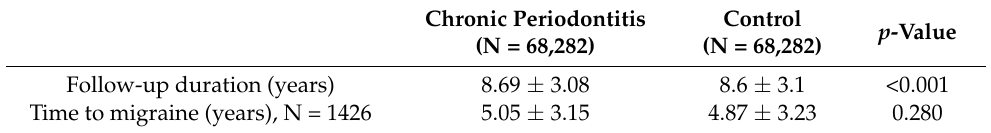
Table 3. Track time of chronic periodontitis and control cohort. Chronic Periodontitis